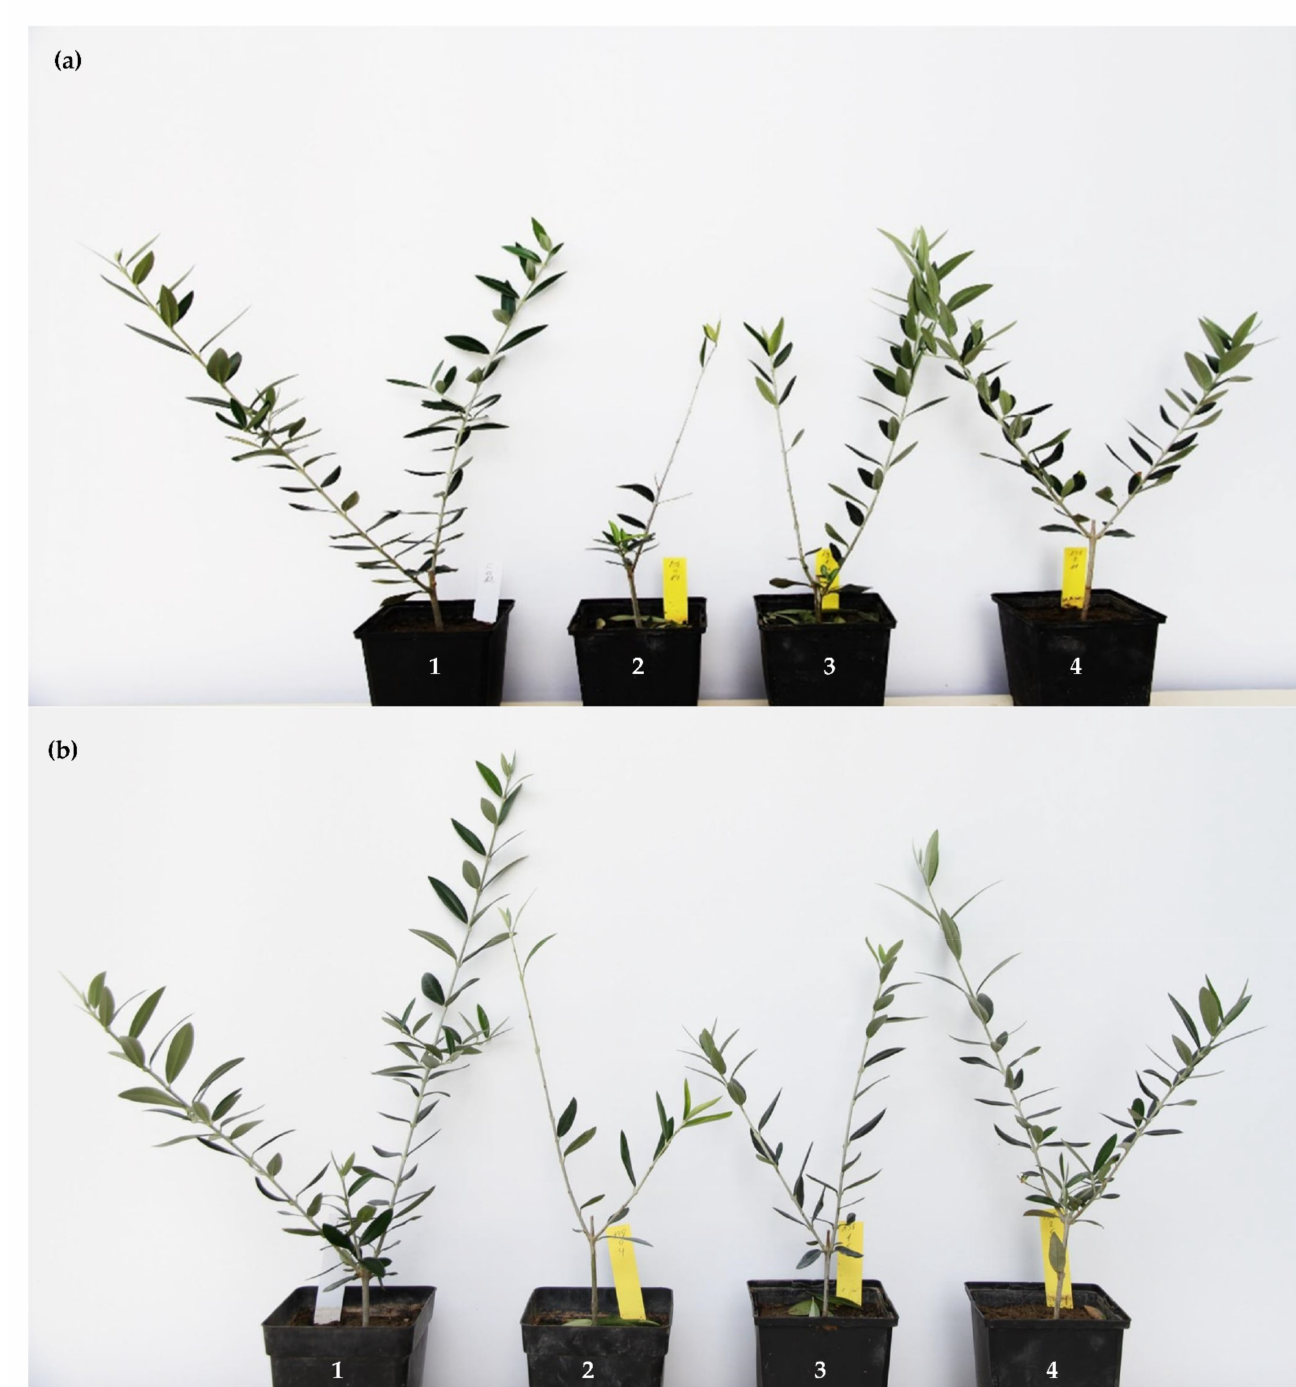
Figure 5. Symptoms of Verticillium wilt in olive plantlets of cv. Picual that grew for 2 months in soil infested with the defoliating pathotype V136I 1A of Verticillium dahliae treated with the blend of PTS and PTSO in 1:1 proportion at different concentrations: ( a ) Plants that were not further treated with AP; ( b ) Plants that were treated once with 100 mL one week later via irrigation. In both panels ( a , b ), the following can be observed: (1) Negative control group without fungal inoculation or treatment, (2) Positive control group that grew in soil infested with V. dahliae and not treated. (3) Plants that grew in V. dahliae infected soil treated with the blend of PTS/PTSO at 250 µ g/mL and (4) Infected test group treated with the blend of PTS/PTSO at 500 µ